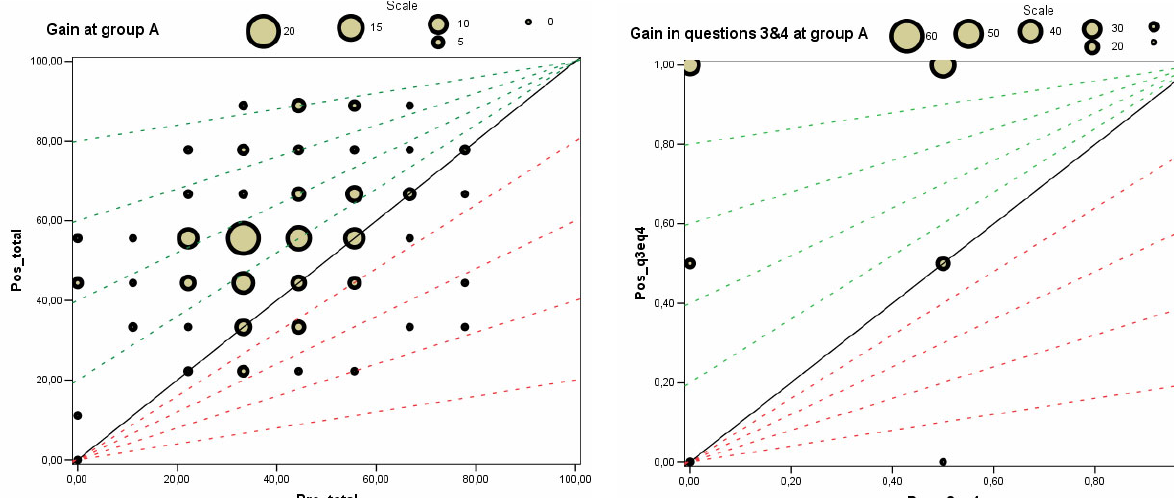
Figure 8. Gain results in the total questionnaire, for group A students